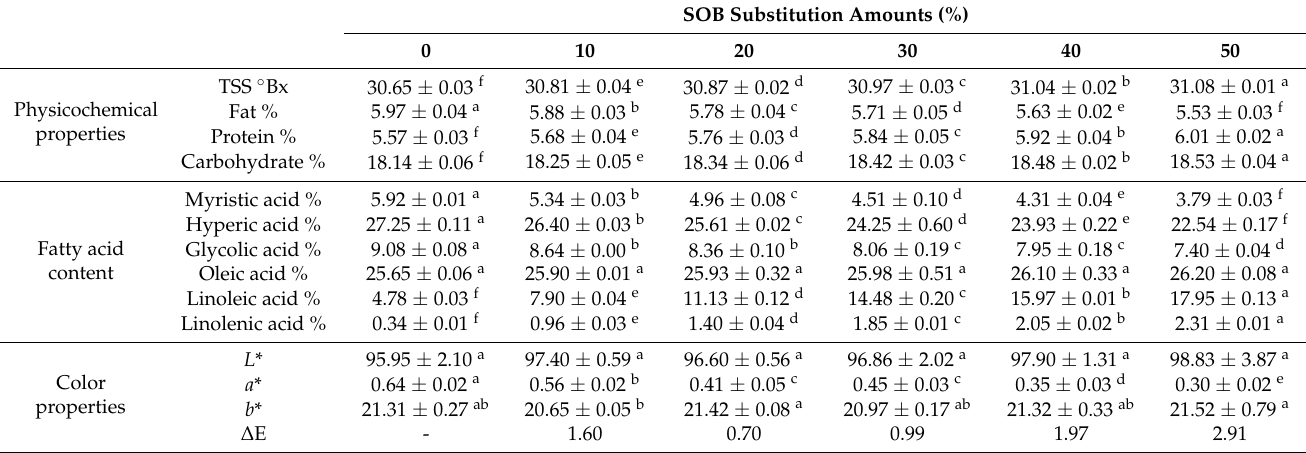
Table 3. Effects of different SOB substitution amounts on the physicochemical parameters of ice